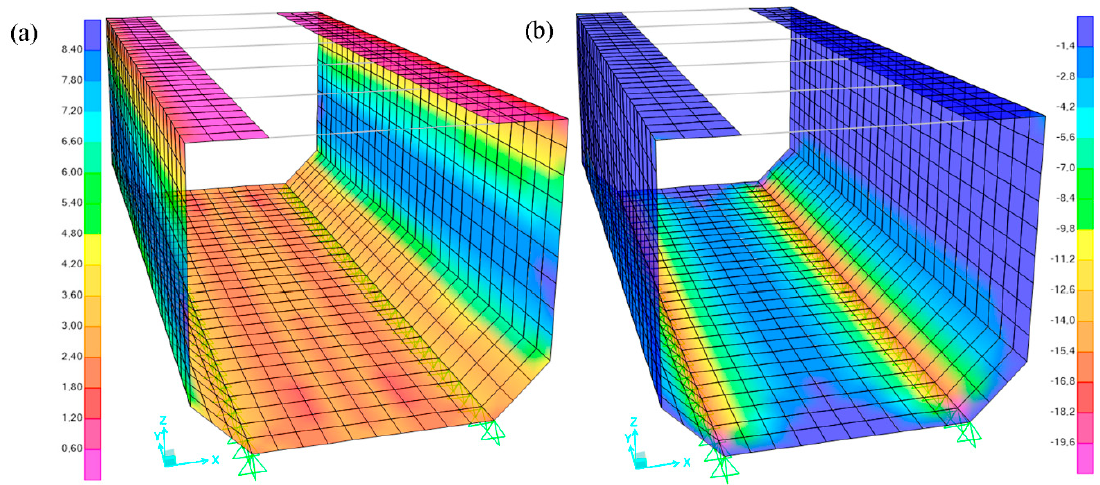
Figure 8. Bending moment envelopes (mkN/m) for the combination C 2 : ( a ) M 11, dmax and ( b ) M 11, dmin .